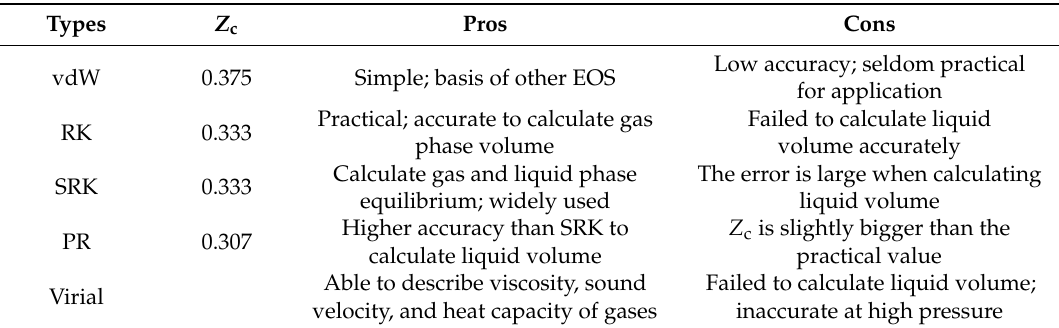
Table 4. Typical EOS of describing real gas behaviors